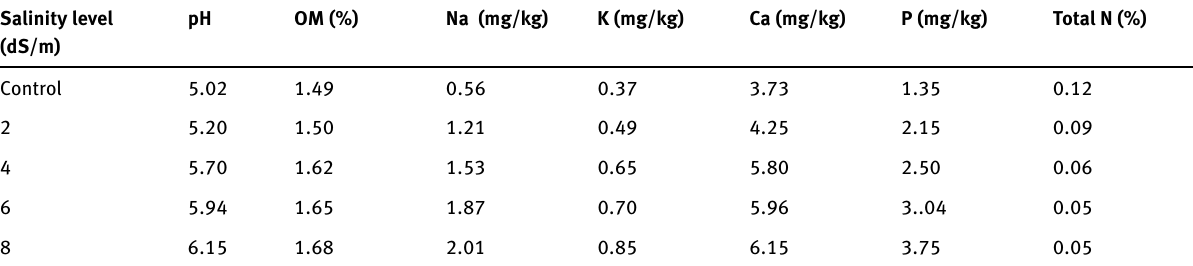
Table 1. Physico-chemical properties of post-harvest soil from the experimental pots. Salinity